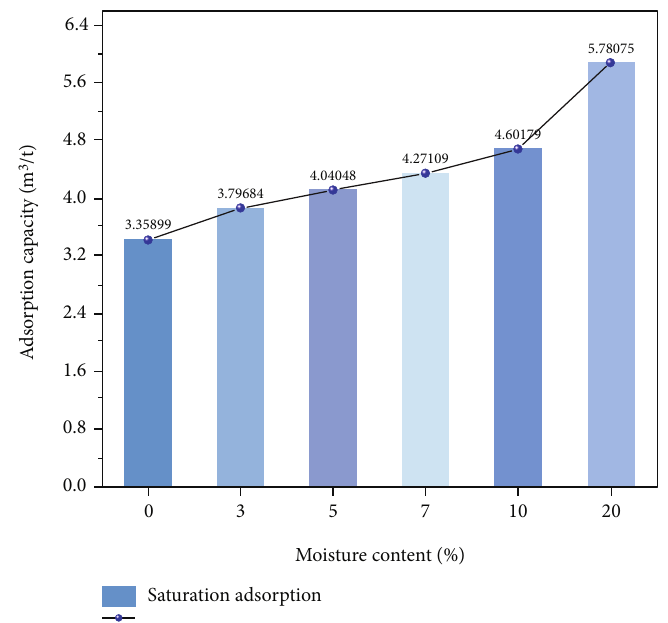
Figure 7: Relationship between water content of coal samples and saturation adsorption